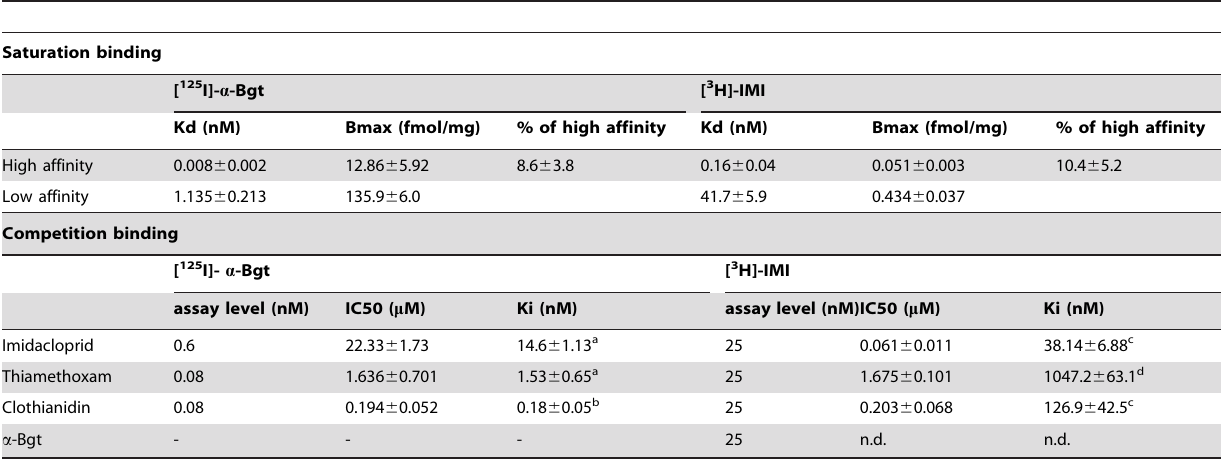
found that the three neonicotinoids TMX, CLT, and IMI have Table 3. [ 125 I]- a -Bungarotoxin ([ 125 I]- a -Bgt) and [ 3 H]-imidacloprid ([ 3 H]-IMI) binding parameters determined on aphid